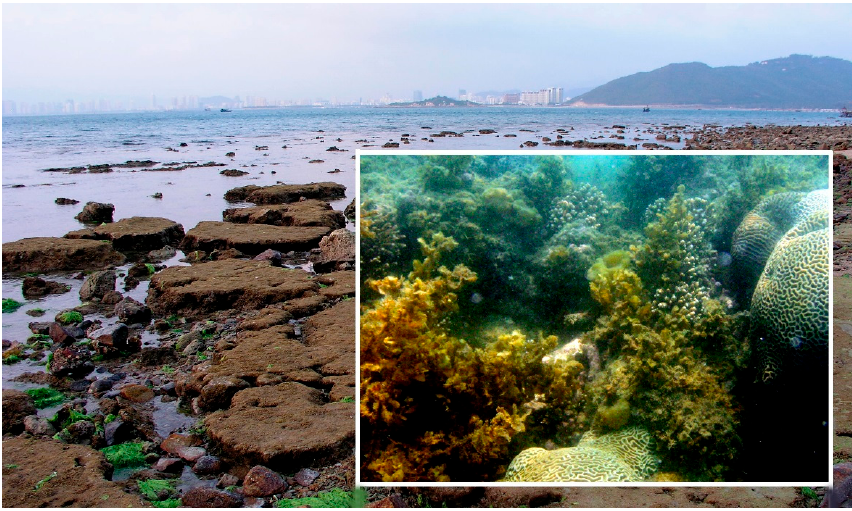
Figure 2. Sanya Bay, Luhuitou Peninsula, the intertidal zone at low tide. Inset: The uppersubtidal zone, March 2012.